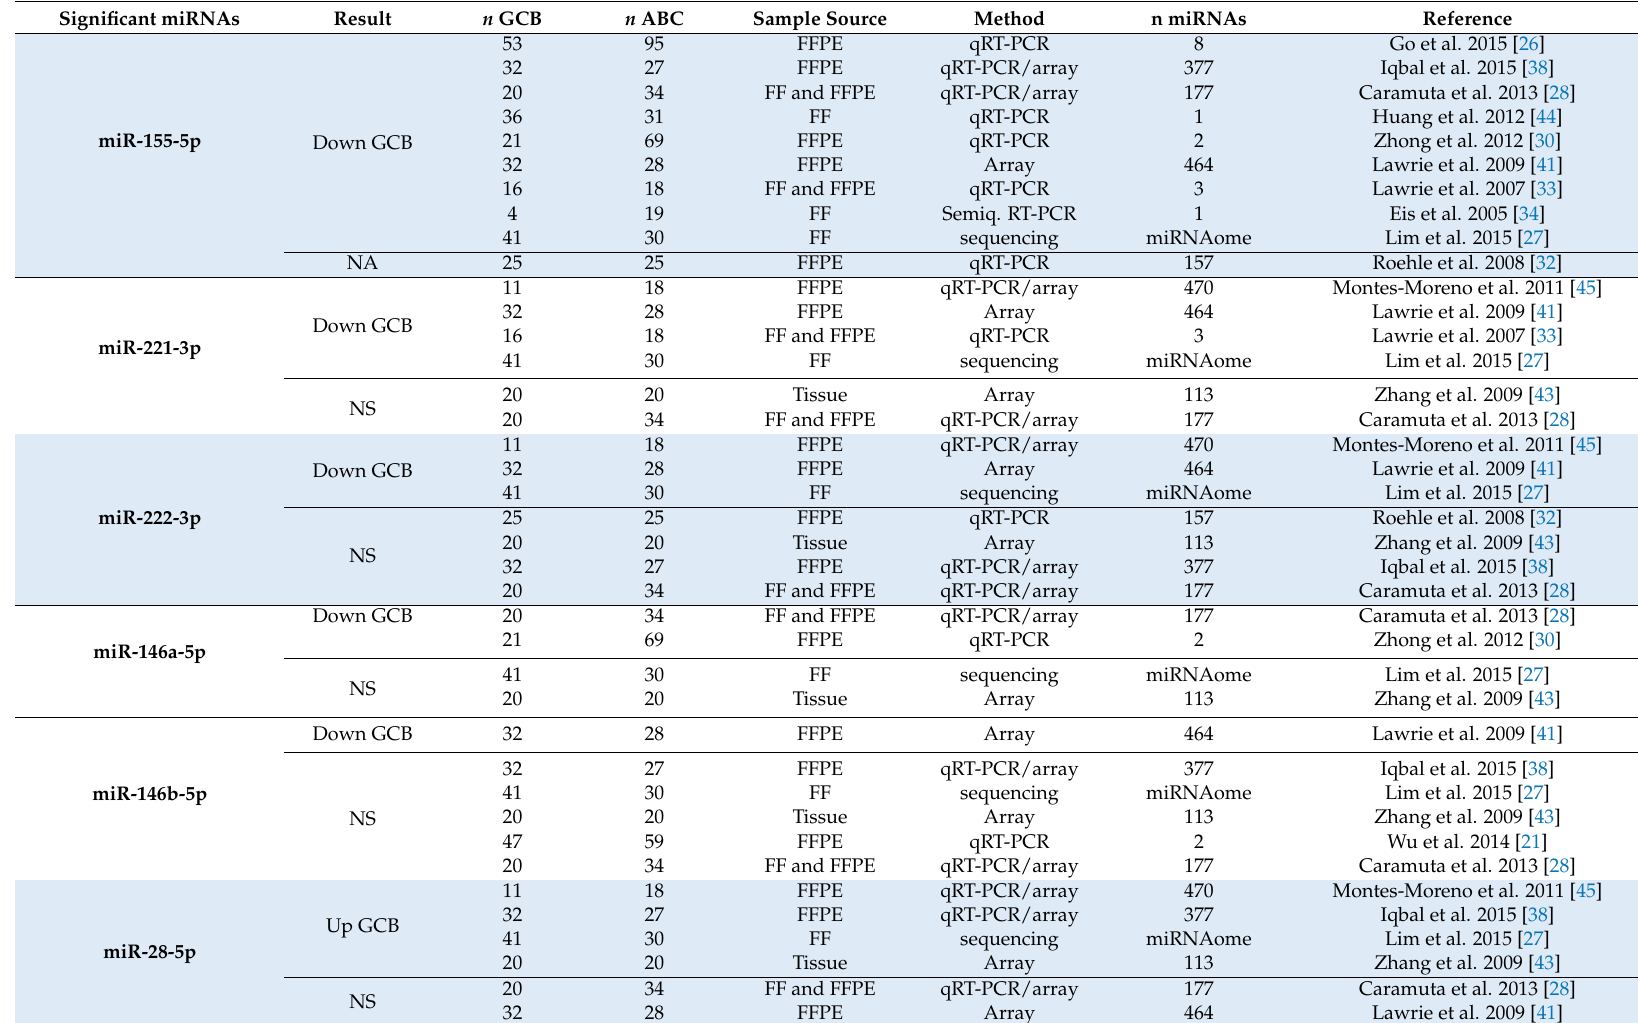
Table 2. miRNAs significantly associated with DLBCL subtype in more than two